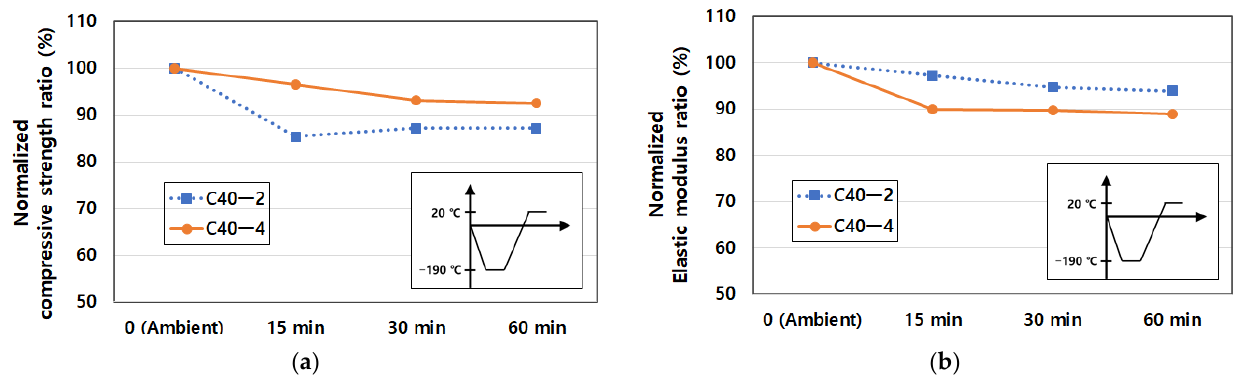
Figure 9. Normalized mechanical properties exposed to cryogenic temperature: ( a ) normalized compressive strength over temperature and ( b ) normalized elastic modulus over temperature.